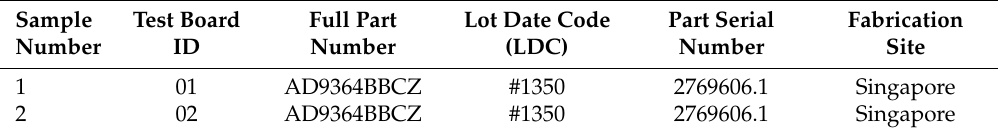
Table 1. Part and test information table.